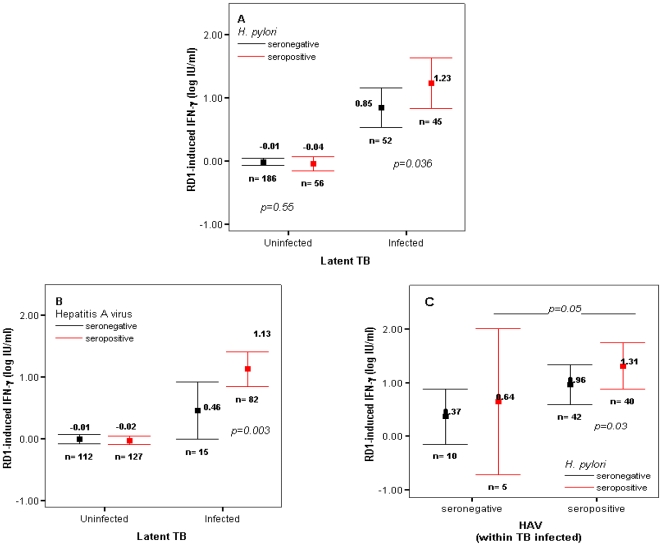
IFN-γ responses to TB antigens are amplified in concurrently infected subjects.
A: TB antigen induced (24 hour) IFN-γ responses in 97 subjects classified as TB infected [LTBI] and 242 subjects classified as without LTBI, stratified by H. pylori infection status; p-values denote age and sex-adjusted difference within LTBI classification (ANOVA). B. panel A obtained by substituting results of Hepatitis A virus total IgG antibody response [HAV] for H. pylori response; C. mean IFN-γ levels within 97 LTBI+ by H. pylori and HAV antibody test results; p-values denote contrast within each infection grouping. LTBI+: TST≥10 mm induration or QuantiFERON-TB GOLD® positive (≥0.35 IU/ml difference over unstimulated well); LTBI−: TST<10mm and QuantiFERON-TB GOLD®-<0.35 IU/ml; error bars represent 95% confidence interval of the least squares means.